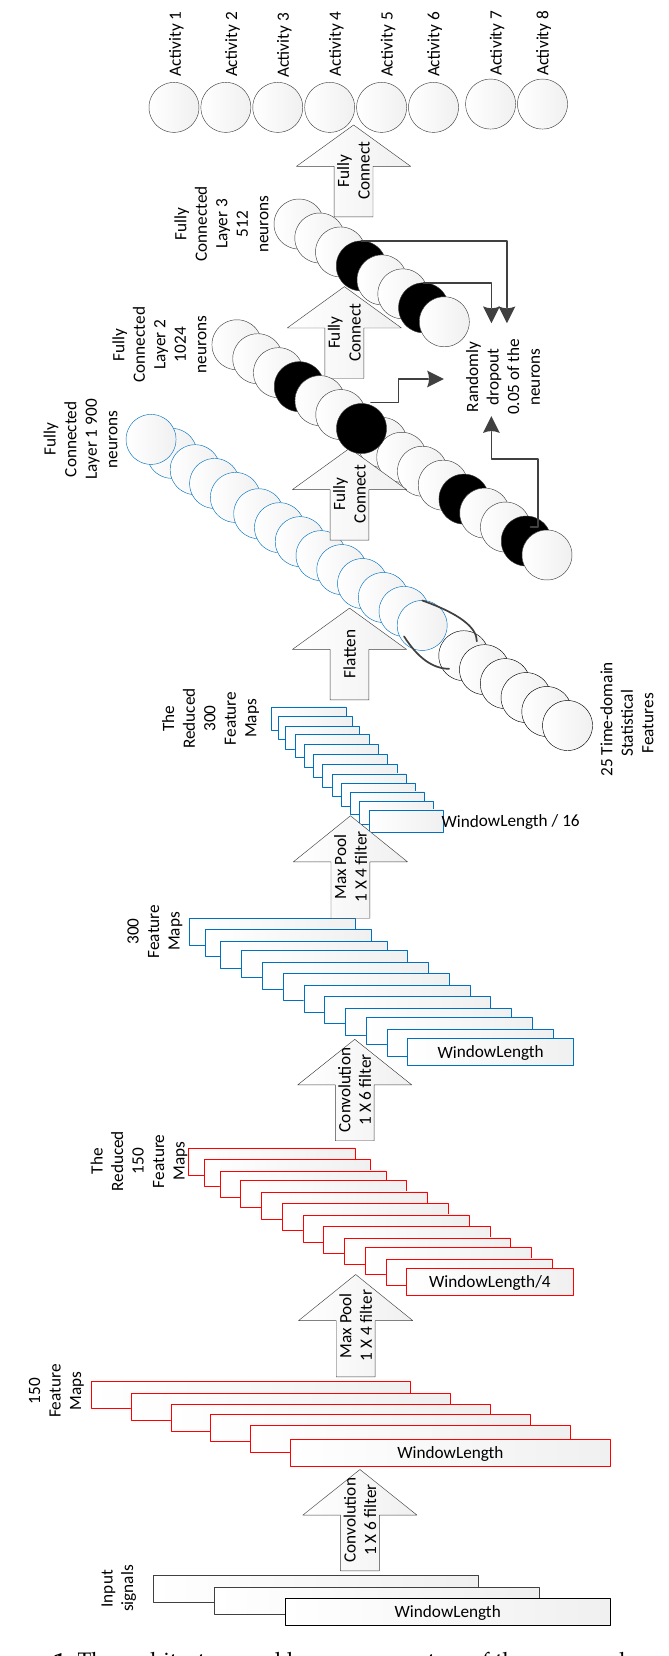
Figure 1. The architecture and hyper-parameters of the proposed